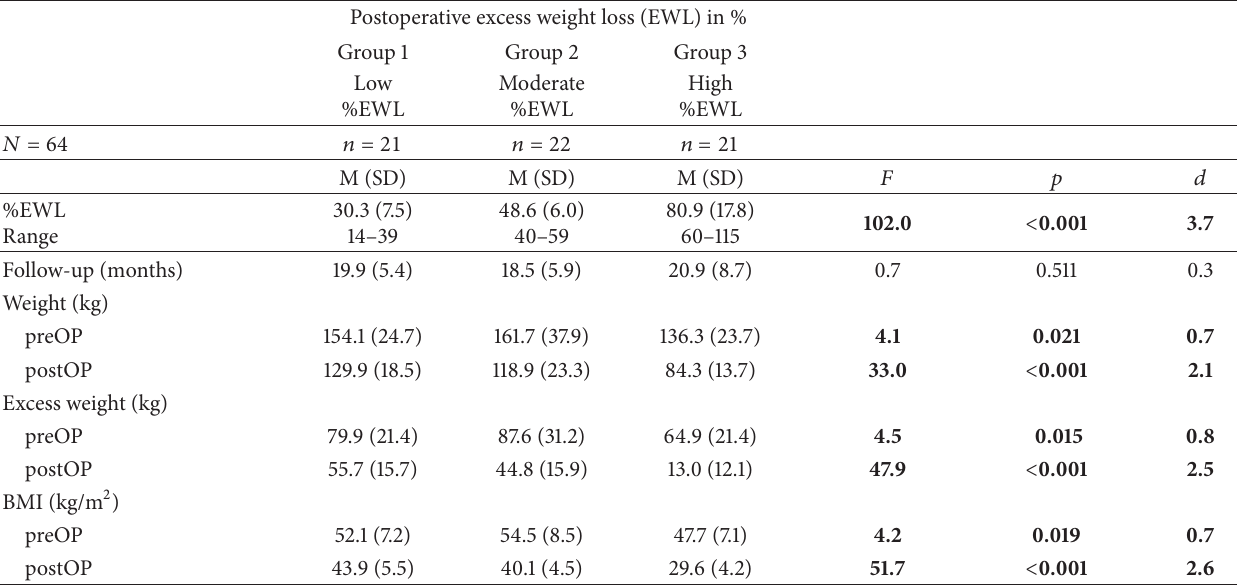
Table 1: Weight and BMI characteristics for groups with low, moderate, and high %EWL before and after laparoscopic sleeve gastrectomy